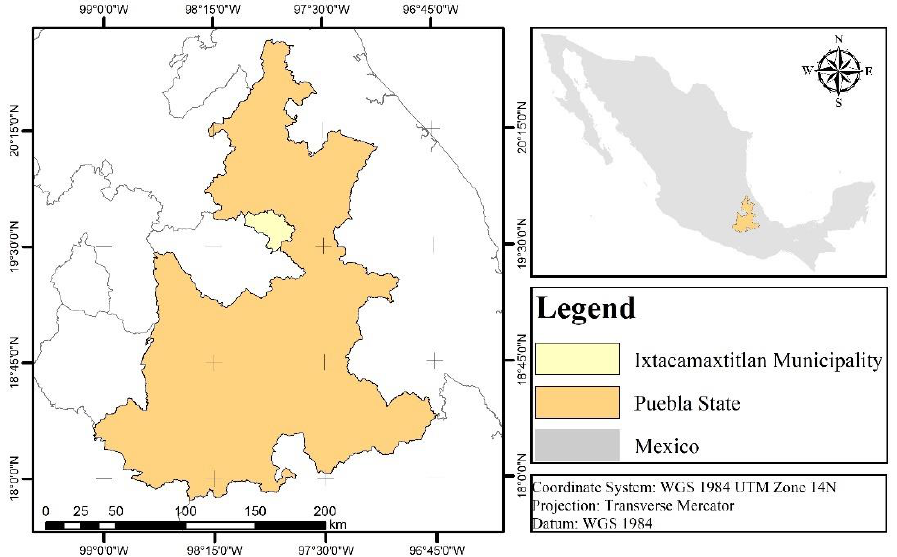
Figure 1. Location of the municipality of Ixtacamaxtitlan, Puebla, Mexico.